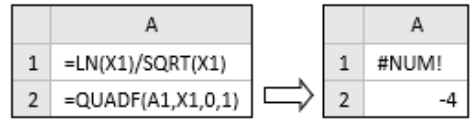
Figure A3 . Demonstration of QUADF for computing integral (A3) in Excel. Figure A3. Demonstration of QUADF for computing integral (A3) in Excel.